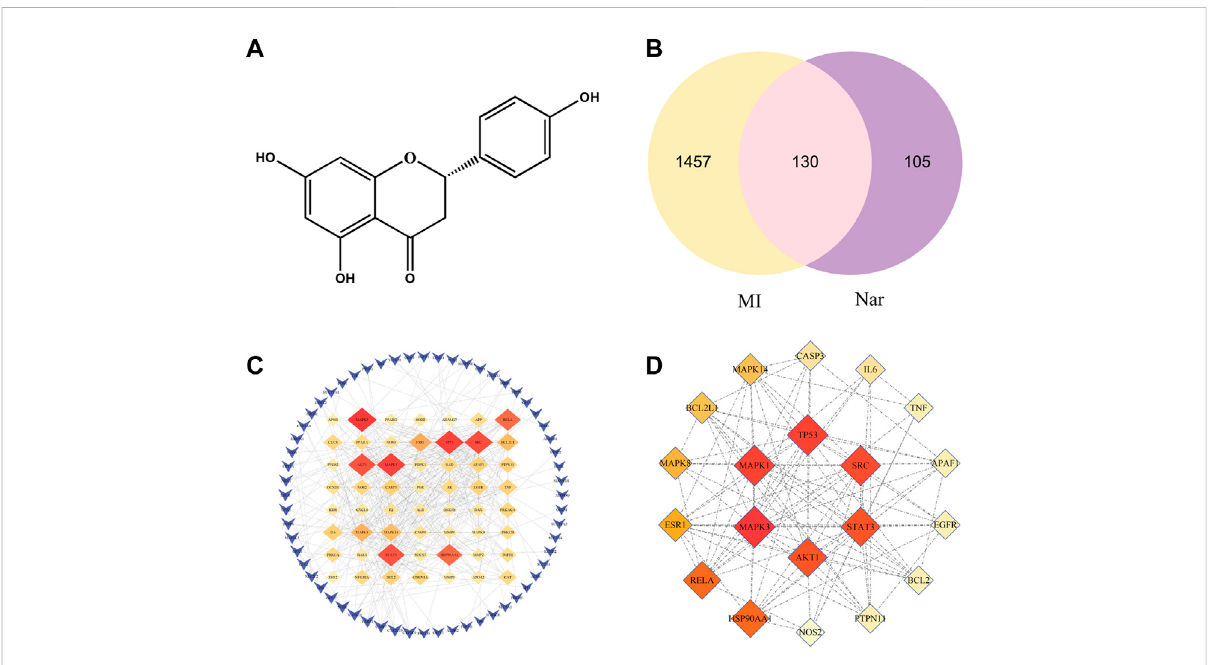
FIGURE 2 Venn diagram and PPI network. (A) Chemical structure of naringenin (Nar). (B) Venn diagram of the intersection target between MI and Nar. (C) PPI network with 130 intersecting targets. (D) Top 20 targets of PPI